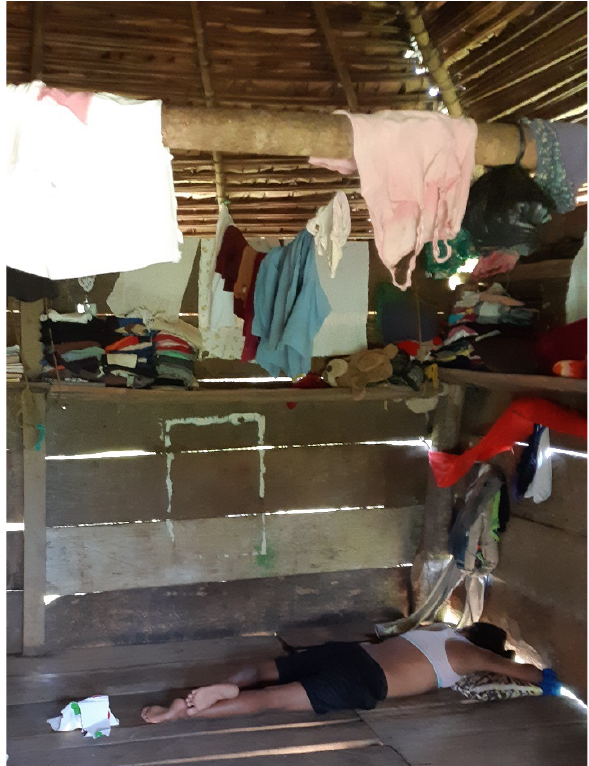
Figure 2. Inner view of a Mayangna dwelling in Santa María, Bonanza (Nathalia González).